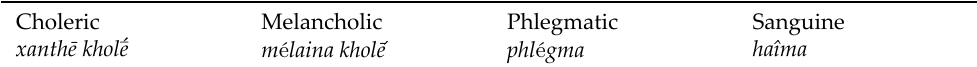
Table 4. The four temperaments.